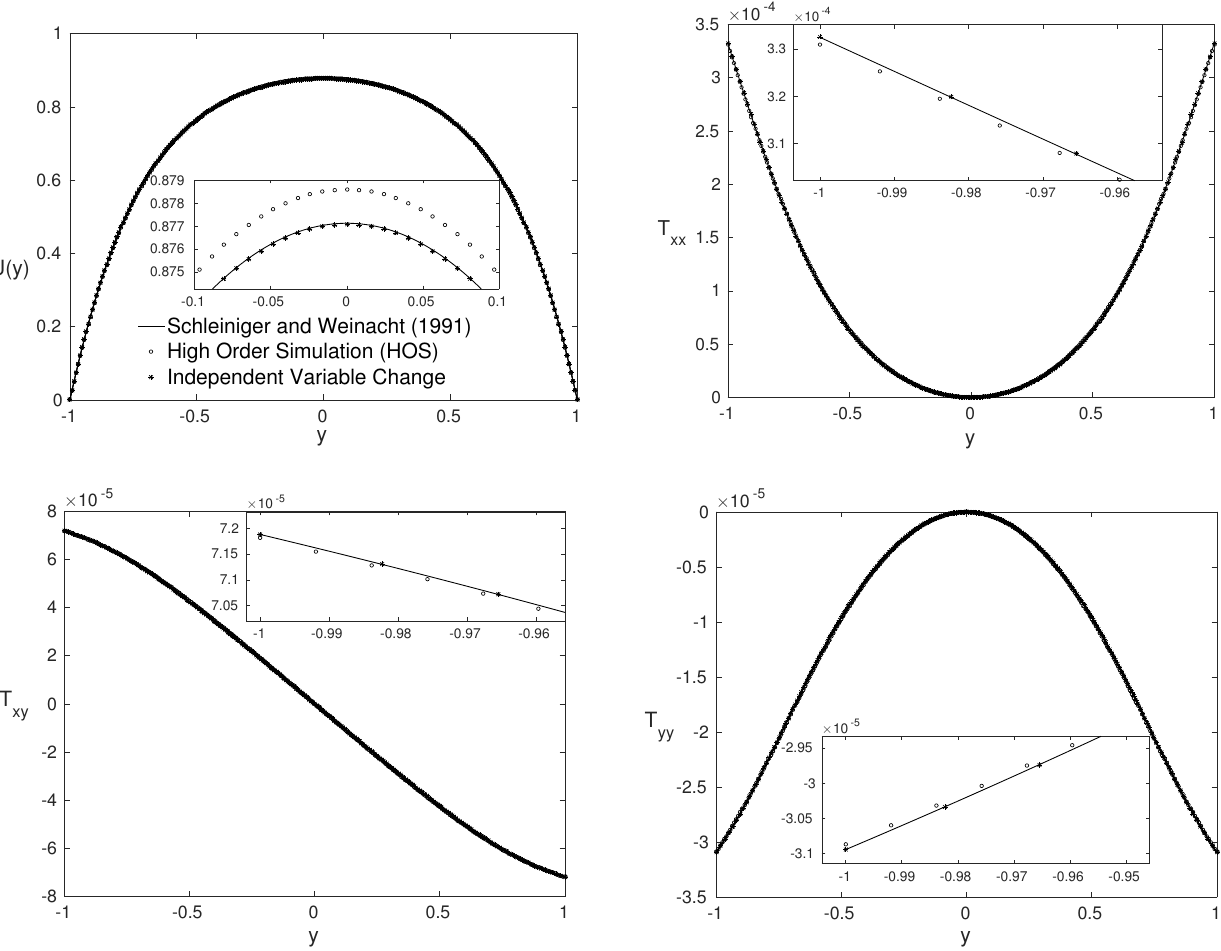
Figure 8. Same as in Figure 1 for dimensionless numbers: Re = 8000, β = 0.05, α G = 0.3 and Wi =